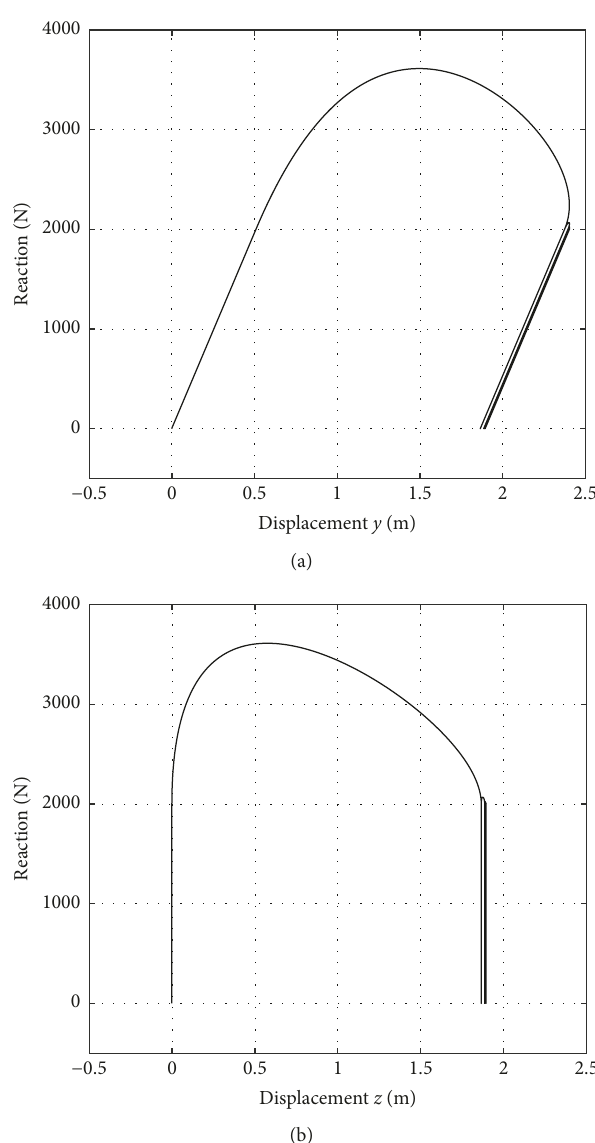
Figure 12: Time history of displacements in elastic-viscoplastic system shown in Figure 3.